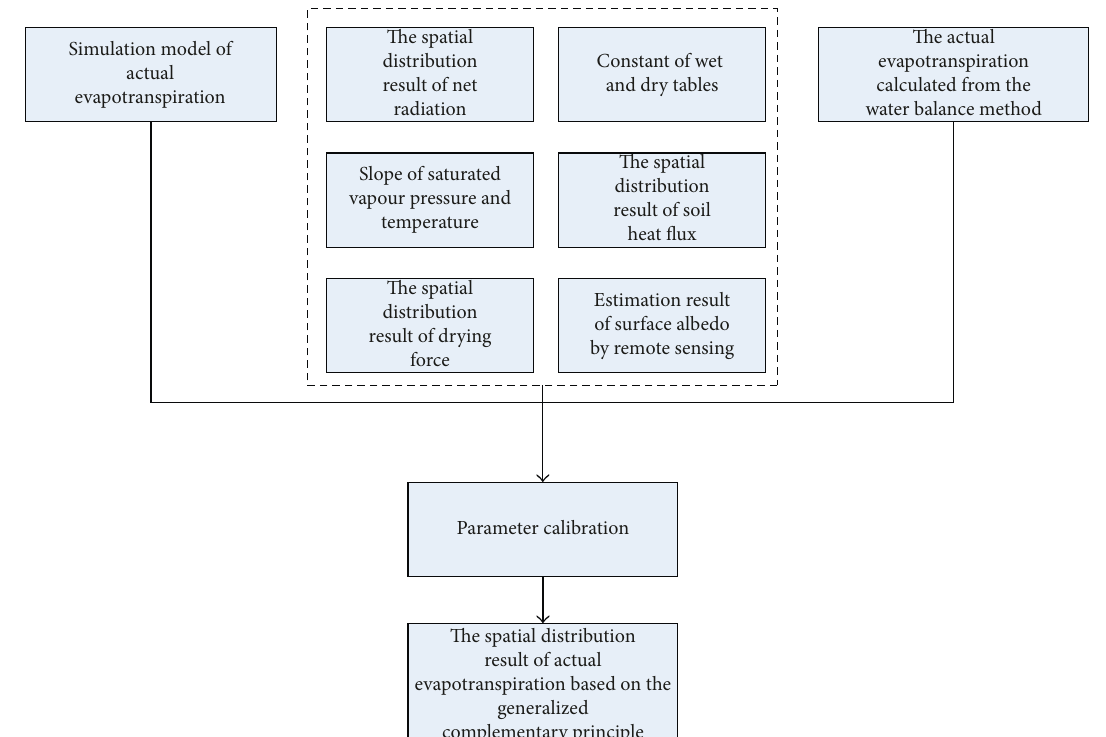
Figure 2: Flow chart of the spatial distribution result of actual evapotranspiration based on the generalized complementary